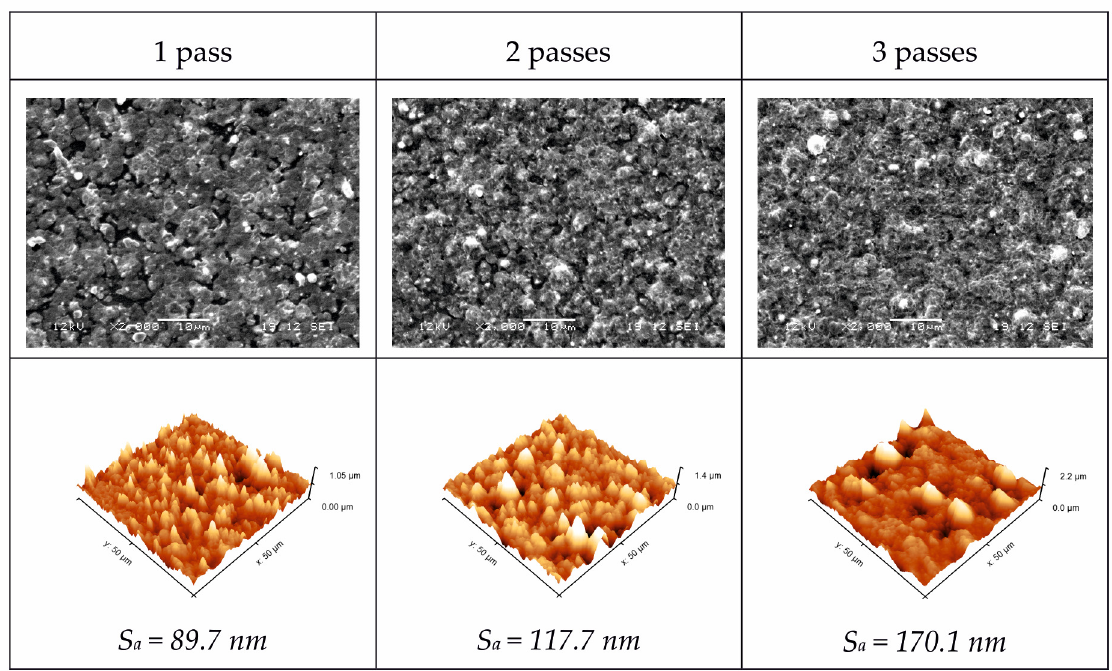
Figure 4. SEM images with a magnification of 2000 × (scale bar 10 µ m) and 3D AFM images with the surface roughness of the coated glass surfaces at different numbers of passes.